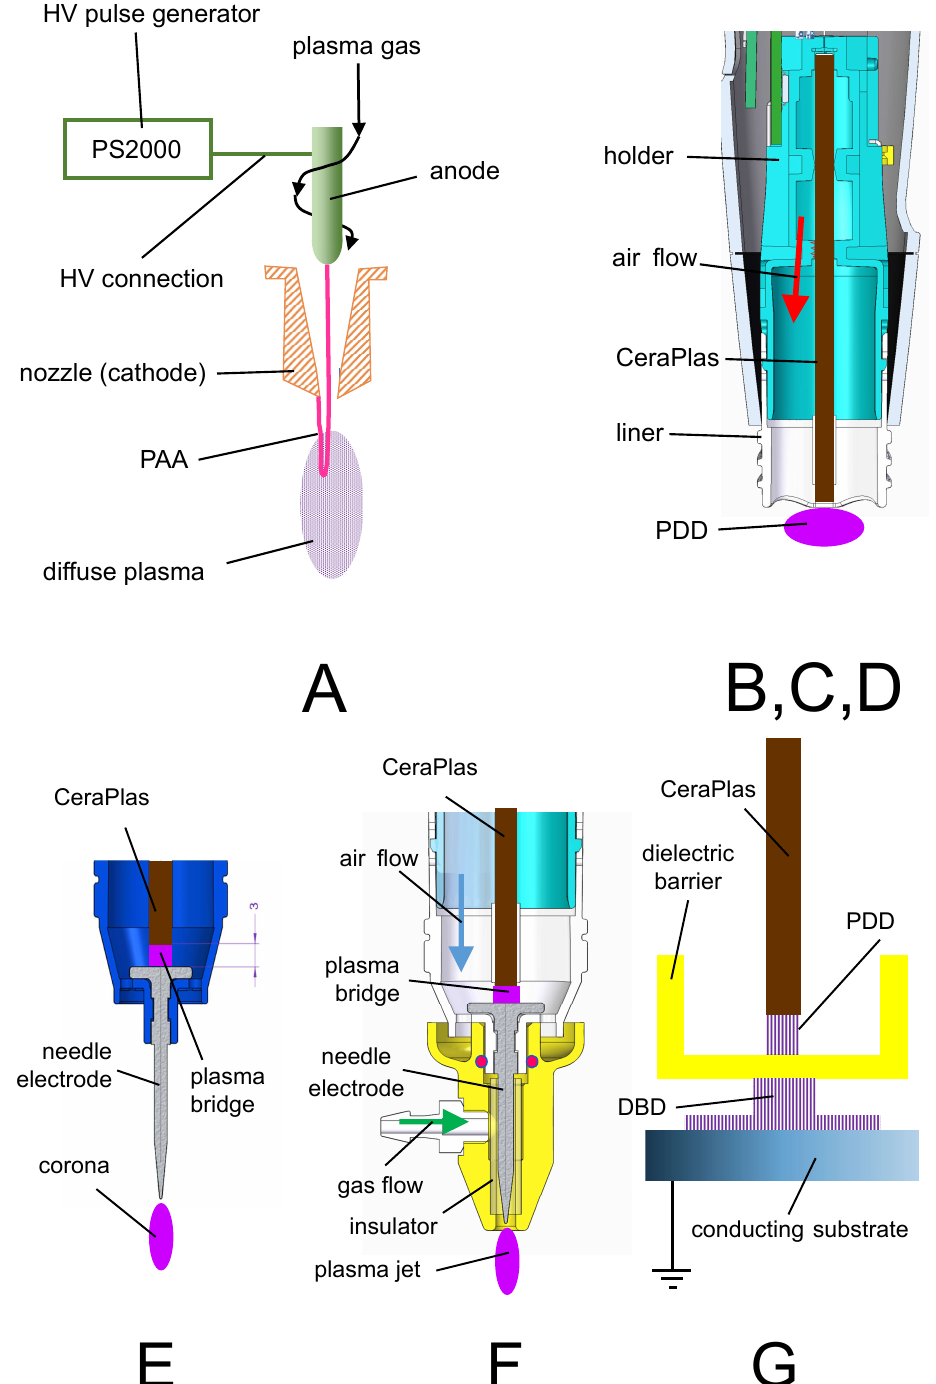
Figure 1. Discharge configurations. A—pulsed atmospheric arc (PAA) based APPJ, (B, C, D— piezoelectric direct discharge (PDD), E—piezoelectrically driven needle corona, F—piezoelectrically driven plasma needle discharge, and G—piezoelectrically driven dielectric barrier discharge